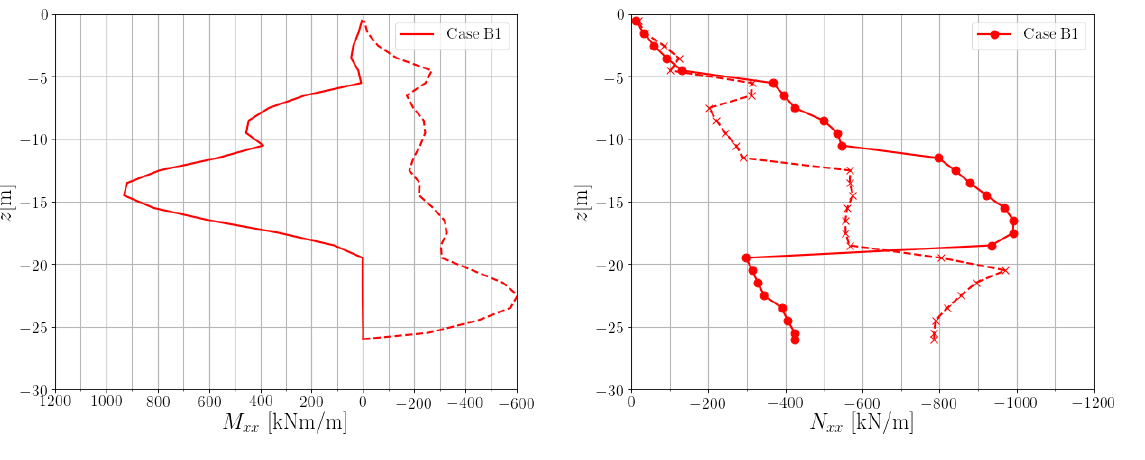
Figure 9: Envelope of characteristic bending moments (Case B1) and corresponding membrane forces at the time instance when the foundation raft is